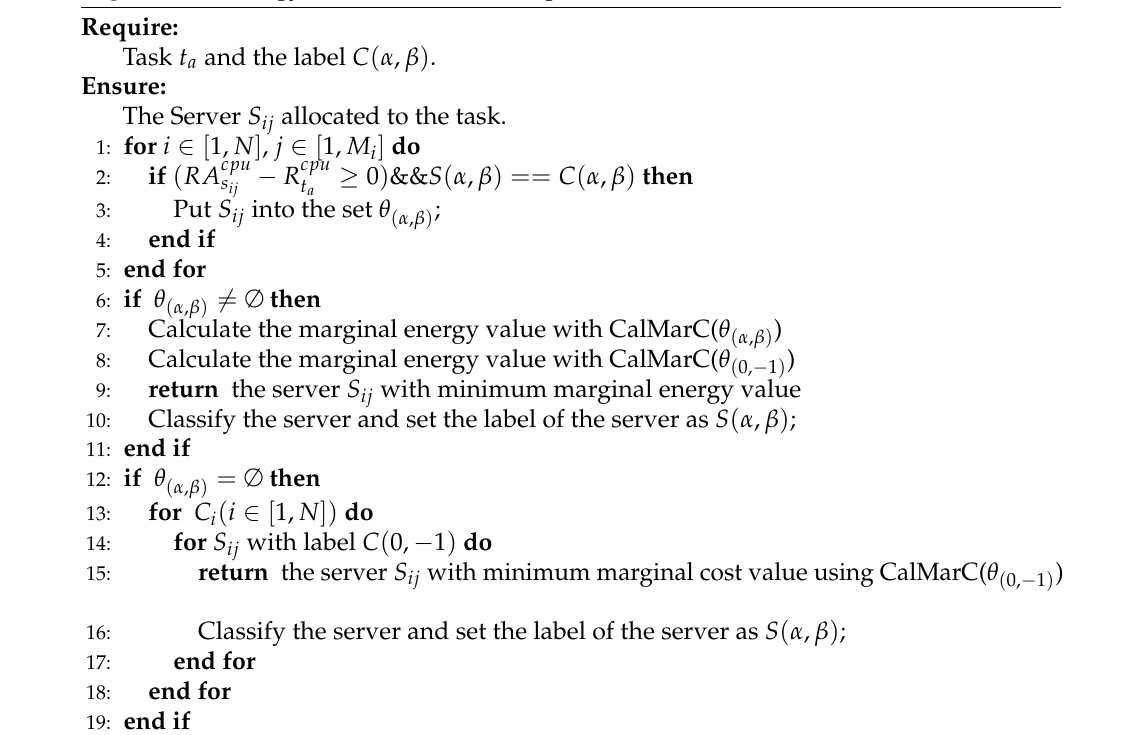
Algorithm 1 Energy-aware task